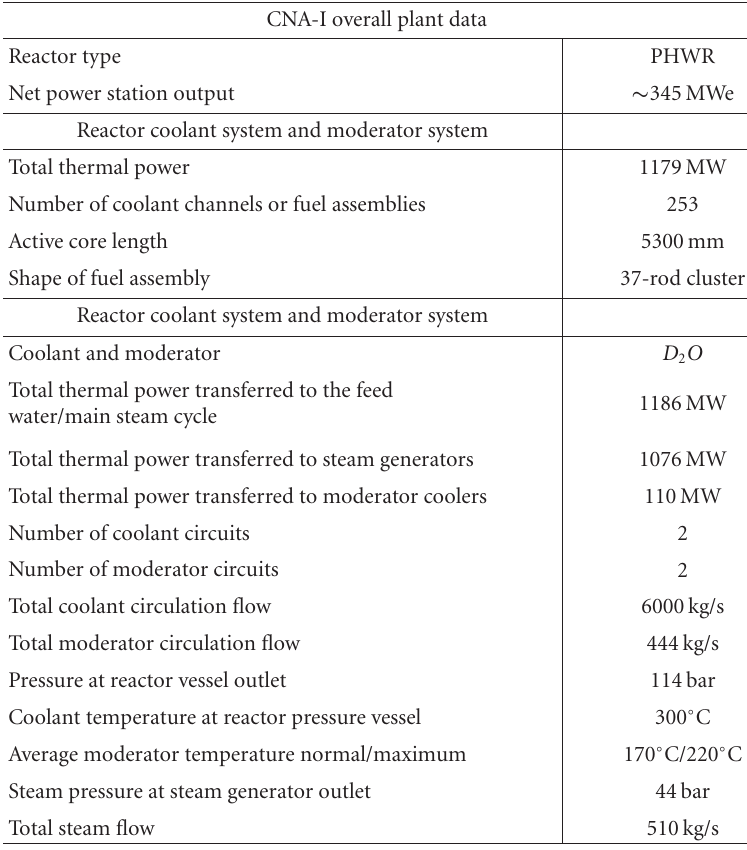
Table 1: CNA-I PHWR NPP overall